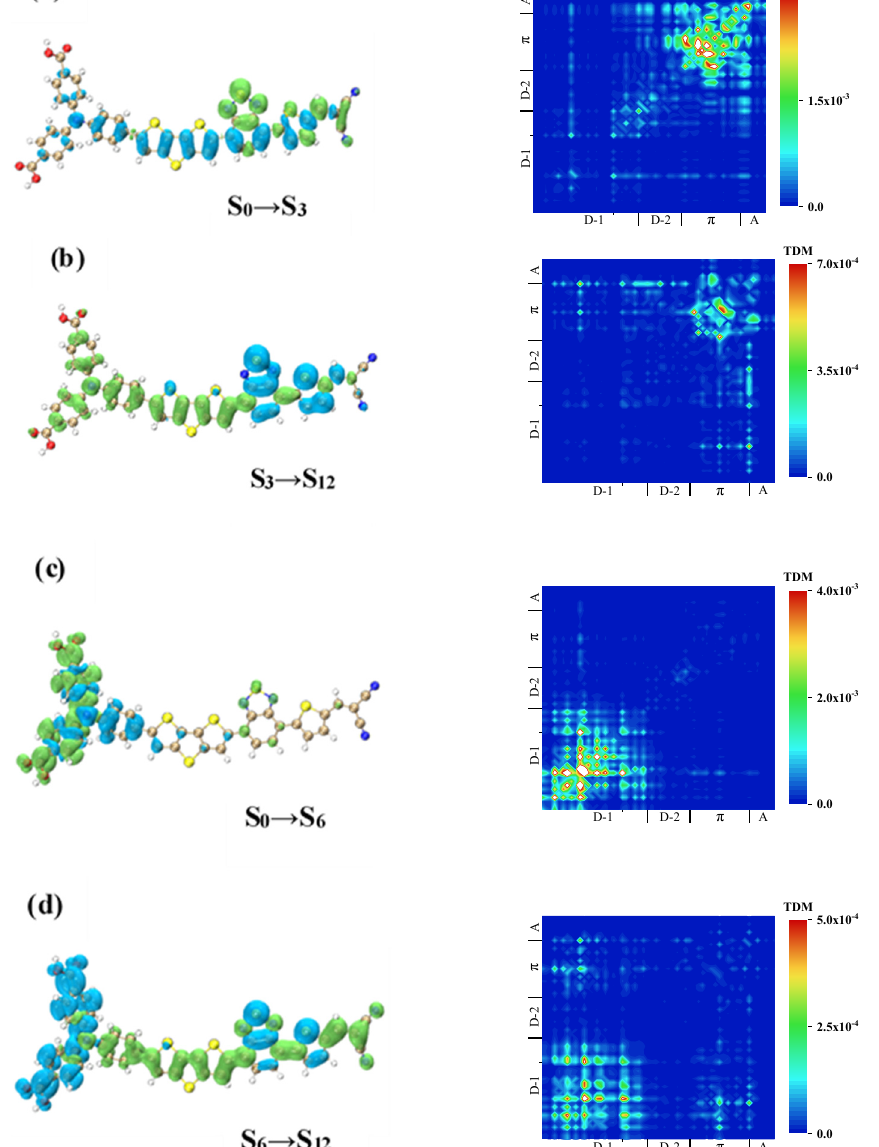
Figure 11. TDM and CDD of WS7 in TPA. TDM and CDD of S 0 → S 3 ( a ) of WS7, TDM and CDD of